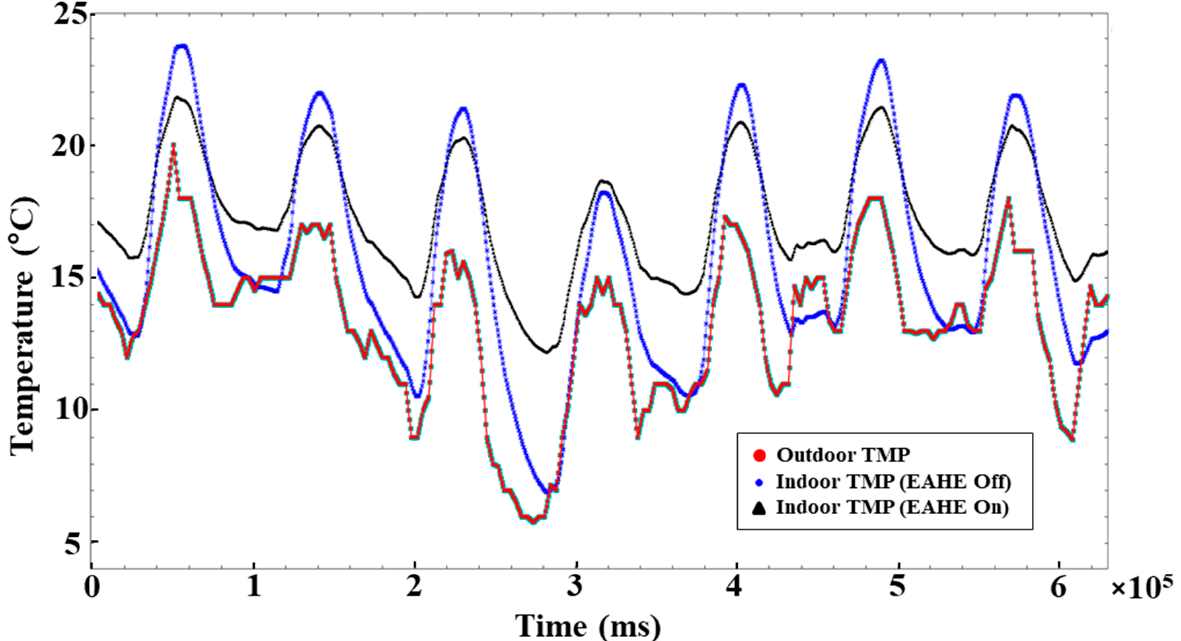
Figure 23. Magnified section of the experimental and co-simulation results.